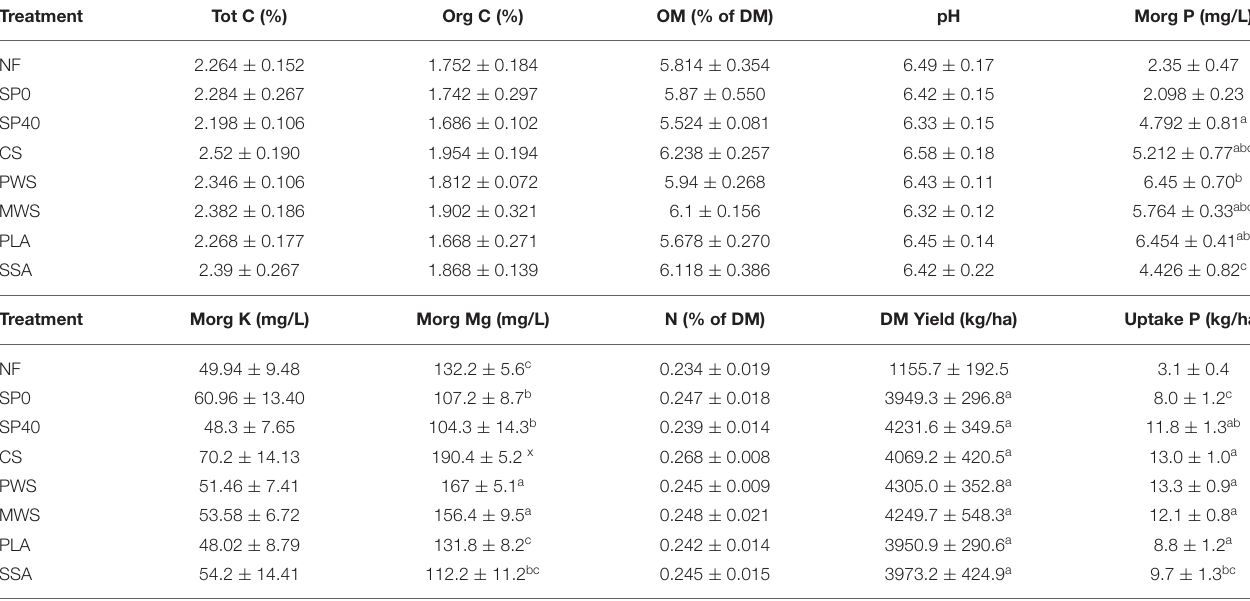
TABLE 3 | Soil physiochemical properties of treatments, crop yield and P uptake after the second ryegrass harvest.